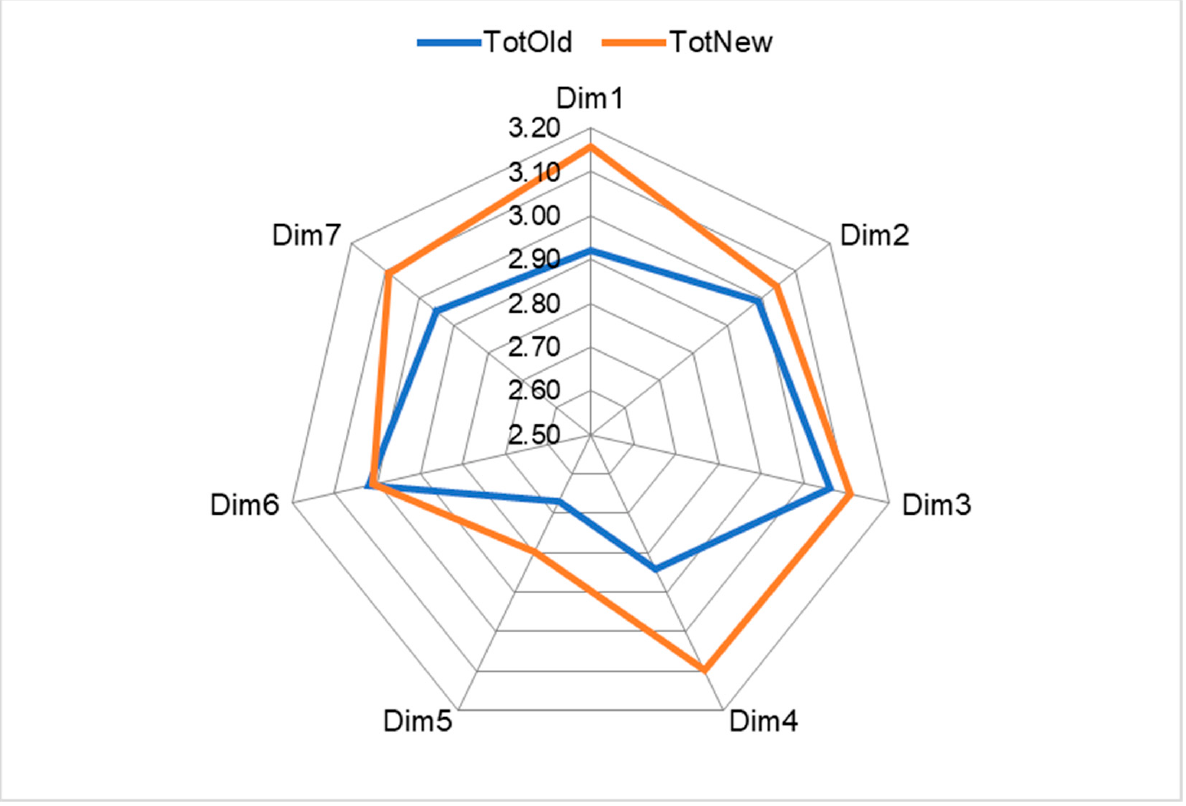
Figure 5. Overall results of the NOSACQ-50 questionnaire in the current study (TotNew) compared to those of previous